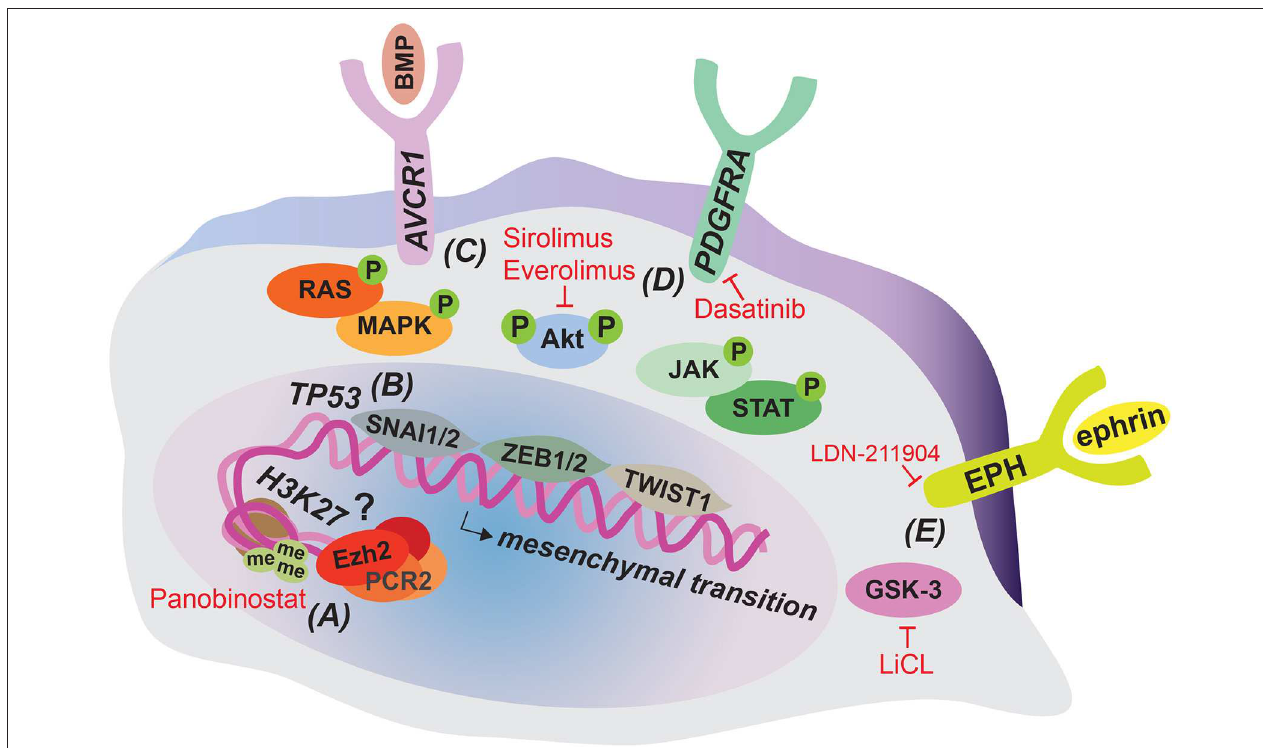
FIGURE 1 | Tumor cell-intrinsic alterations that can contribute to DIPG invasion and strategies for their therapeutic targeting. The majority of DIPG tumors harbor a H3K27M mutation resulting in epigenetic dysregulation that might contribute to invasion and can be targeted therapeutically by Panobinostat (A) . Loss of function mutations in TP53 are common in DIPG and can enhance migratory cell behavior by inducing the mesenchymal transcription factor SNAI1 (B) . Gain of function mutations in AVCR1 (C) and PDGFRA (D) activate downstream RAS/MAPK, PI3K/Akt, and JAK/STAT signaling, which can induce invasion associated mesenchymal transition through SNAI1/2, ZEB1/2, and TWIST1 transcription factors. Enhanced PI3K/Akt signaling can be therapeutically targeted by Sirolimus and Everolimus and PDGFRA signaling by Dasatinib. EPH-ephrin signaling and GSK-3 have been implicated in migratory behavior in DIPG cell cultures and can be targeted therapeutically by LDN-211904 and LiCL, respectively (E)